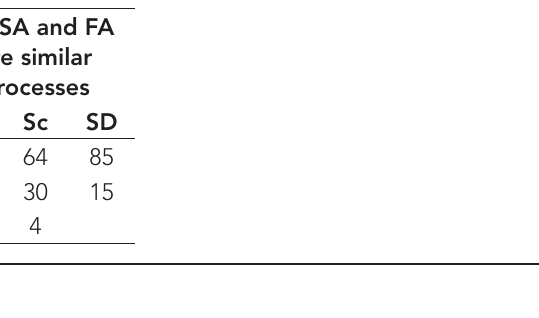
Table 15: Are you sure how SA and FA relate to each other? Response